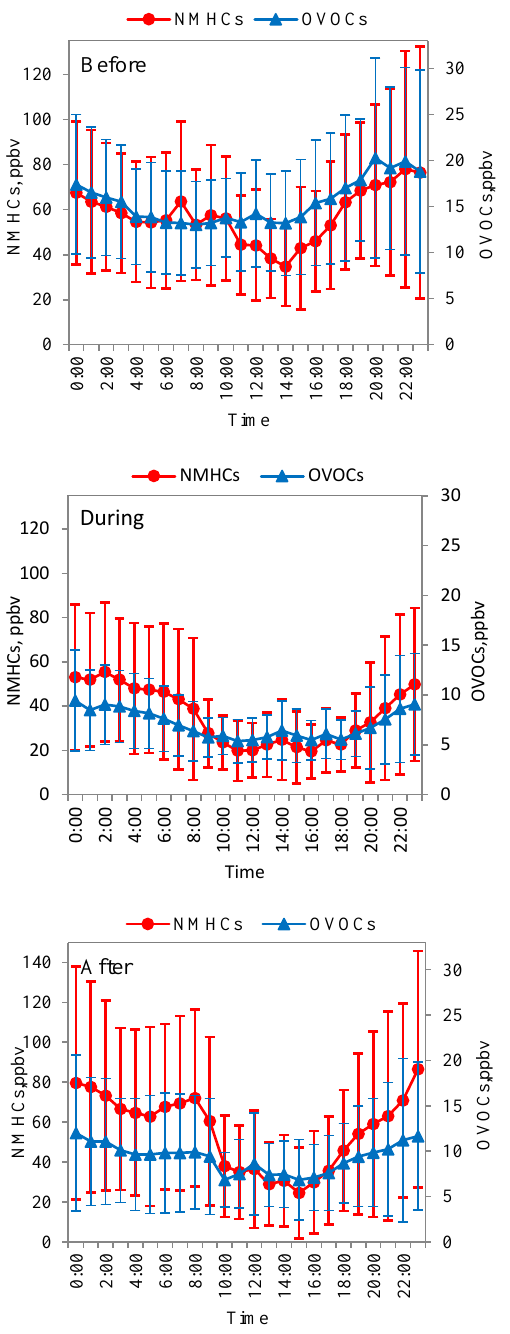
Figure 6. Diurnal variations of mixing ratios of 2,2-dimethylbutane and acetylene at the PKU site before, during, and after the control period during APEC China